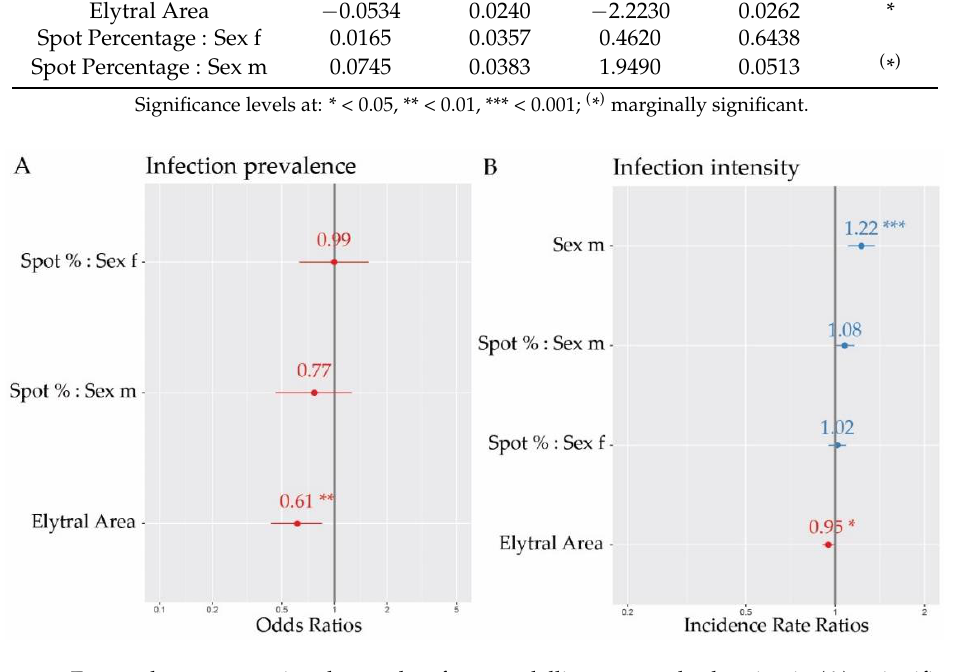
Figure 2. Forest plots representing the results of our modelling approach, showing in ( A ) a significant negative effect of total elytral area on the prevalence of infection of Ha. axyridis with H. virescens and in ( B ) a significantly higher intensity of parasitism in males compared to females as well as a significant negative effect of total elytral area.